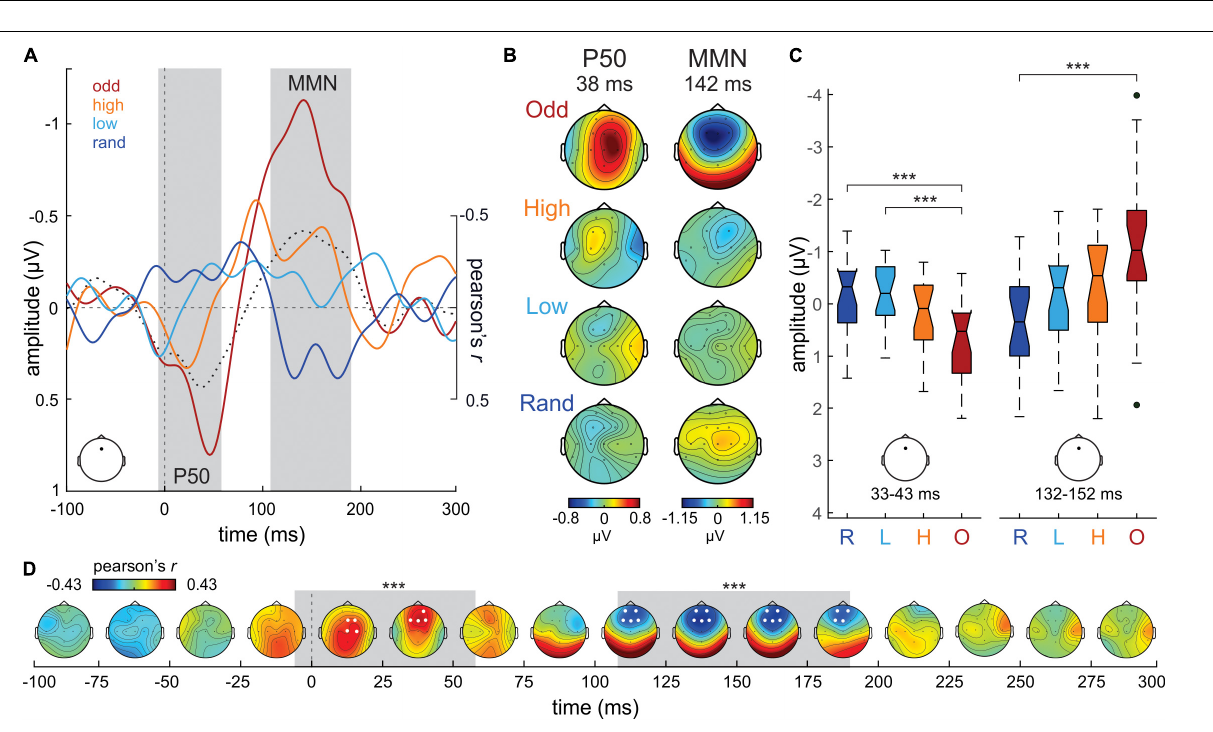
FIGURE 3 | (A) Difference waveforms (D ERP—S ERP) from Fz electrode in the Oddball (odd; dark red), High confidence (high; orange), Low confidence (low; cyan) and Random (rand; dark blue) conditions. Correlation values (Pearson’s r) between S tone probability and DW ERP amplitudes at each time point are plotted in a dotted black line. The gray shaded areas mark the temporal extent of the significant clusters of correlation values (–6–58 ms; 108 to 190 ms). (B) P50 and MMN time range scalp potential distribution maps per condition separately. (C) Boxplot series illustrating the distribution of DW mean amplitude values extracted from Fz around the maximum correlation peaks (38 ms; 142 ms) in our sample of participants, separately per condition and P50/MMN time ranges. The boxplots represent the median value (middle line), the interquartile range (full box) and the extreme values (whiskers; outliers are plotted as separate dots). Significance of post hoc tests: *** p < 0.005. (D) Time-electrode evolution of Pearson’s r -values. The gray shaded areas mark the temporal extent (–6–58 ms; 108–190 ms) of the significant (*** p ≤ 0.005) clusters of correlation values, while the white dots (electrodes) denote their spatial